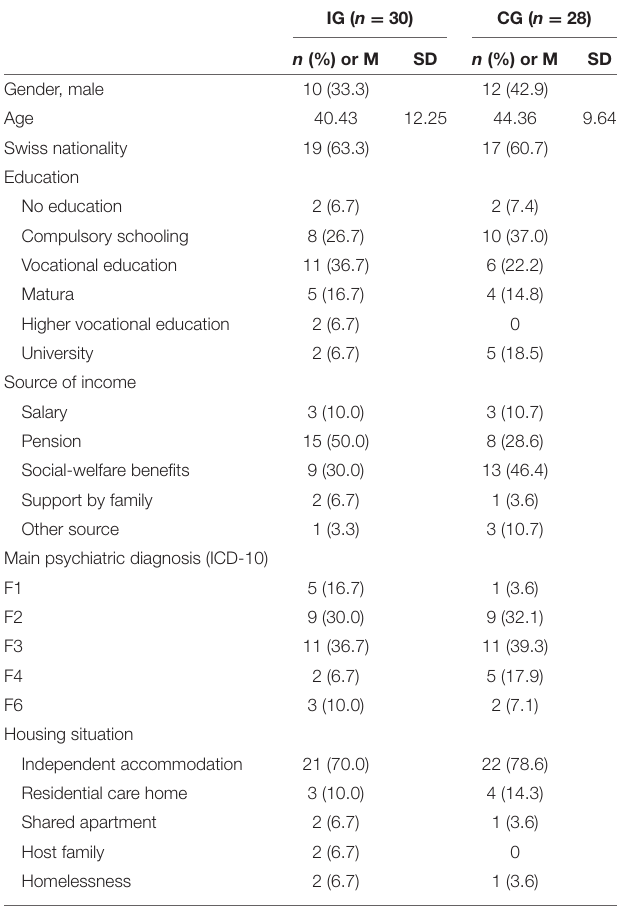
TABLE 1 | Participants’ characteristics at baseline